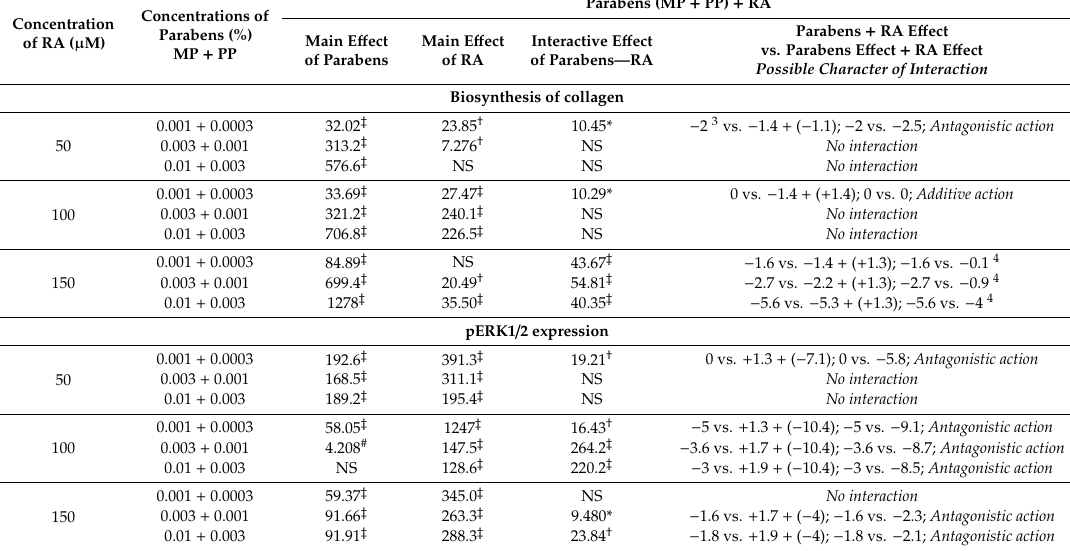
Table 1. Estimation of the main and interactive e ff ects of parabens (methylparaben—MP and propylparaben—PP) and rosmarinic acid (RA) on the biosynthesis of collagen and expression of phosphorylated extracellular signal-regulated kinases (pERK1 / 2) in the human skin fibroblasts 1, 2 . Concentration of RA ( µ